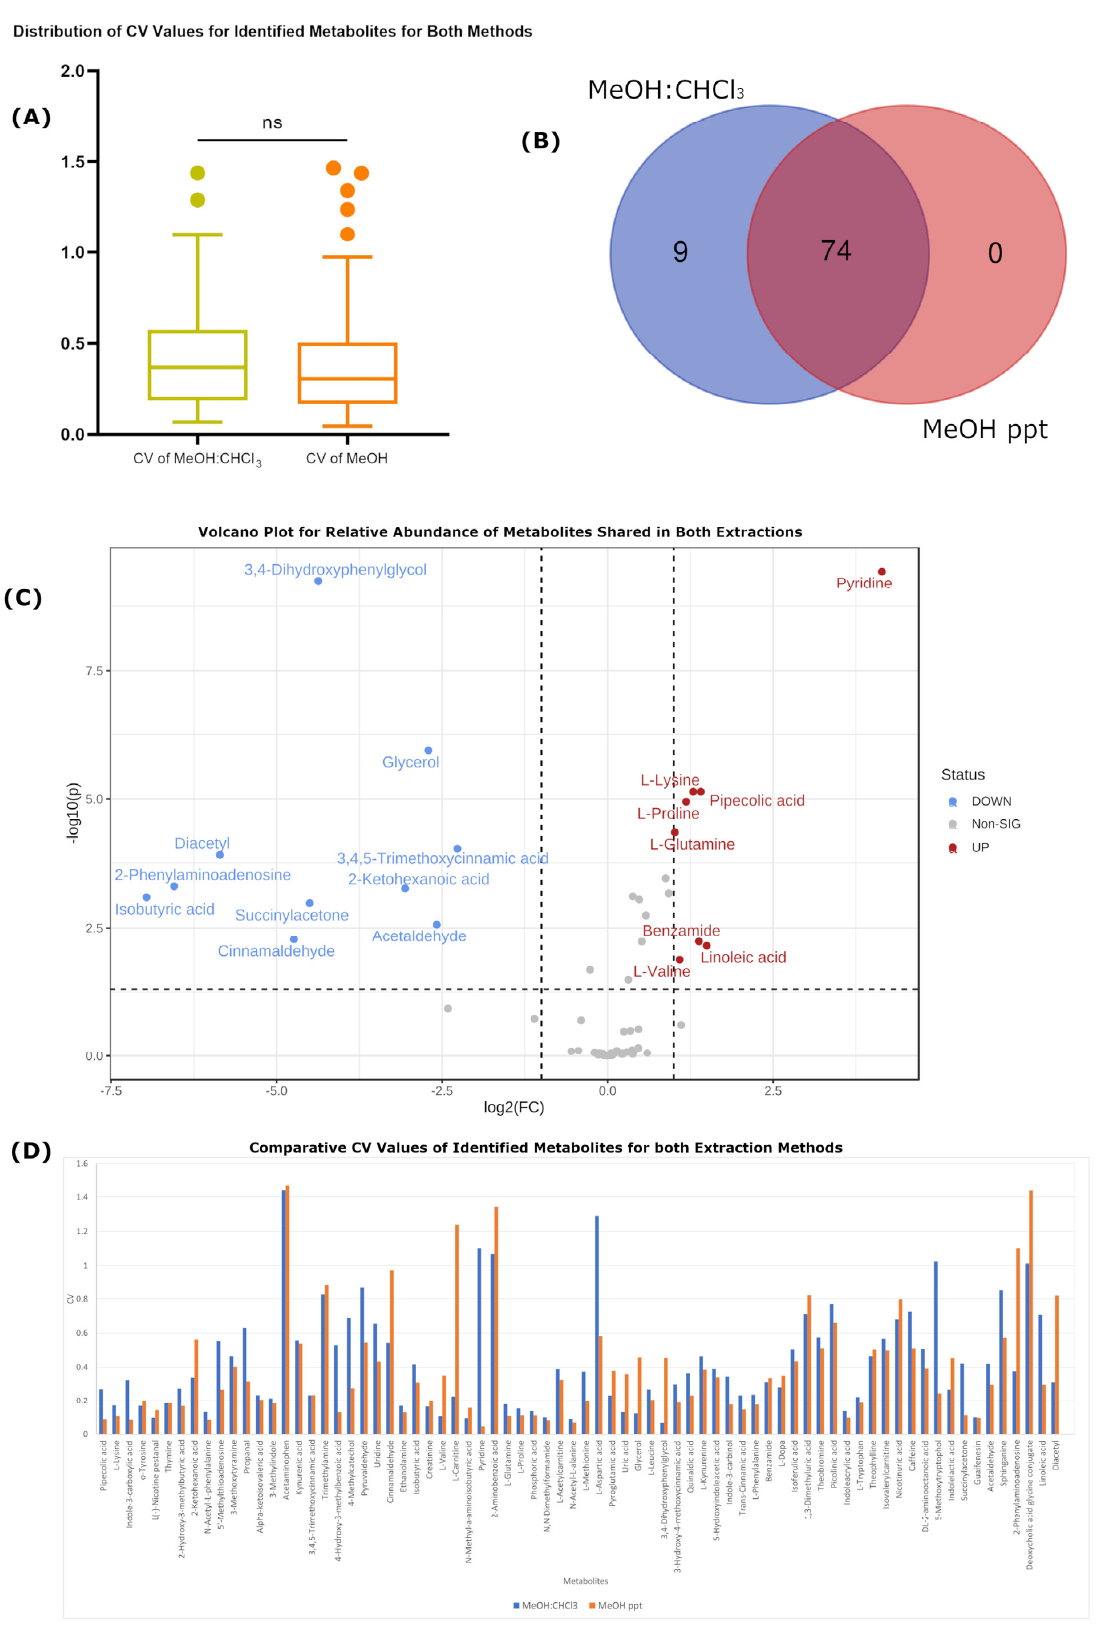
Figure 1. Representation of biological metabolomic variation through different statistical analyses. ( A ) Box plot that shows the distribution of CV values for identified metabolites for both